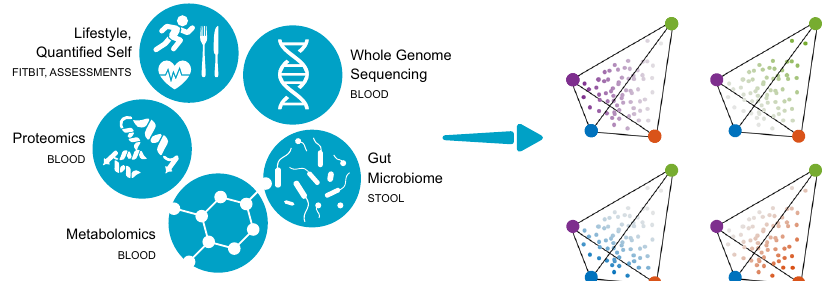
Fig. 1 Pareto task inference of clinical labs — study overview. 67 blood measurements from 3094 individuals were used for the Pareto task inference analysis to fi nd the minimal signi fi cant polyhedron and the position of the archetypes (the vertices). After fi nding the polyhedron using the clinical labs, all other data types (lifestyle self-administered questionnaires and Fitbit records, genomics, microbiome, metabolomics and proteomics) were used to fi nd enriched traits close to every archetype in order to characterize the archetypes and reveal the tradeoffs in the system.